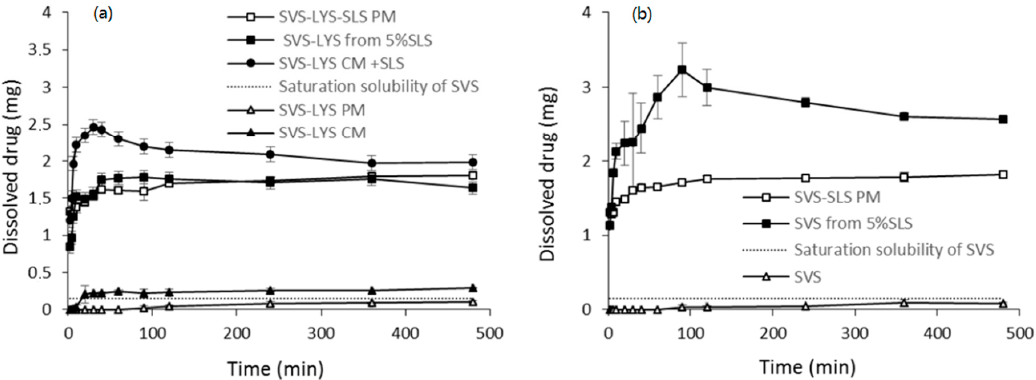
Figure 5. The cumulative amounts of SVS dissolved for ( a ) SVS-LYS formulations and ( b ) SVS formulations in phosphate buffer (pH 7.2). The point of 24 h is not shown, since it was not statistically different from the value obtained at 480 min. The data for SVS, SVS-LYS PM, and SVS-LYS CM formulations is taken from [45].